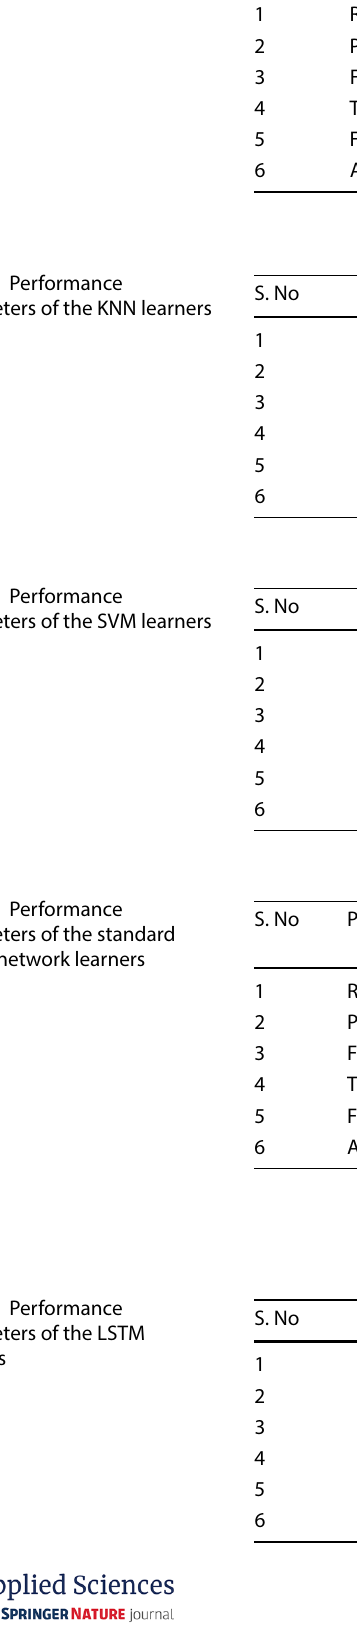
Table 5 Performance parameters of the bi-directional LSTM-RNN learners